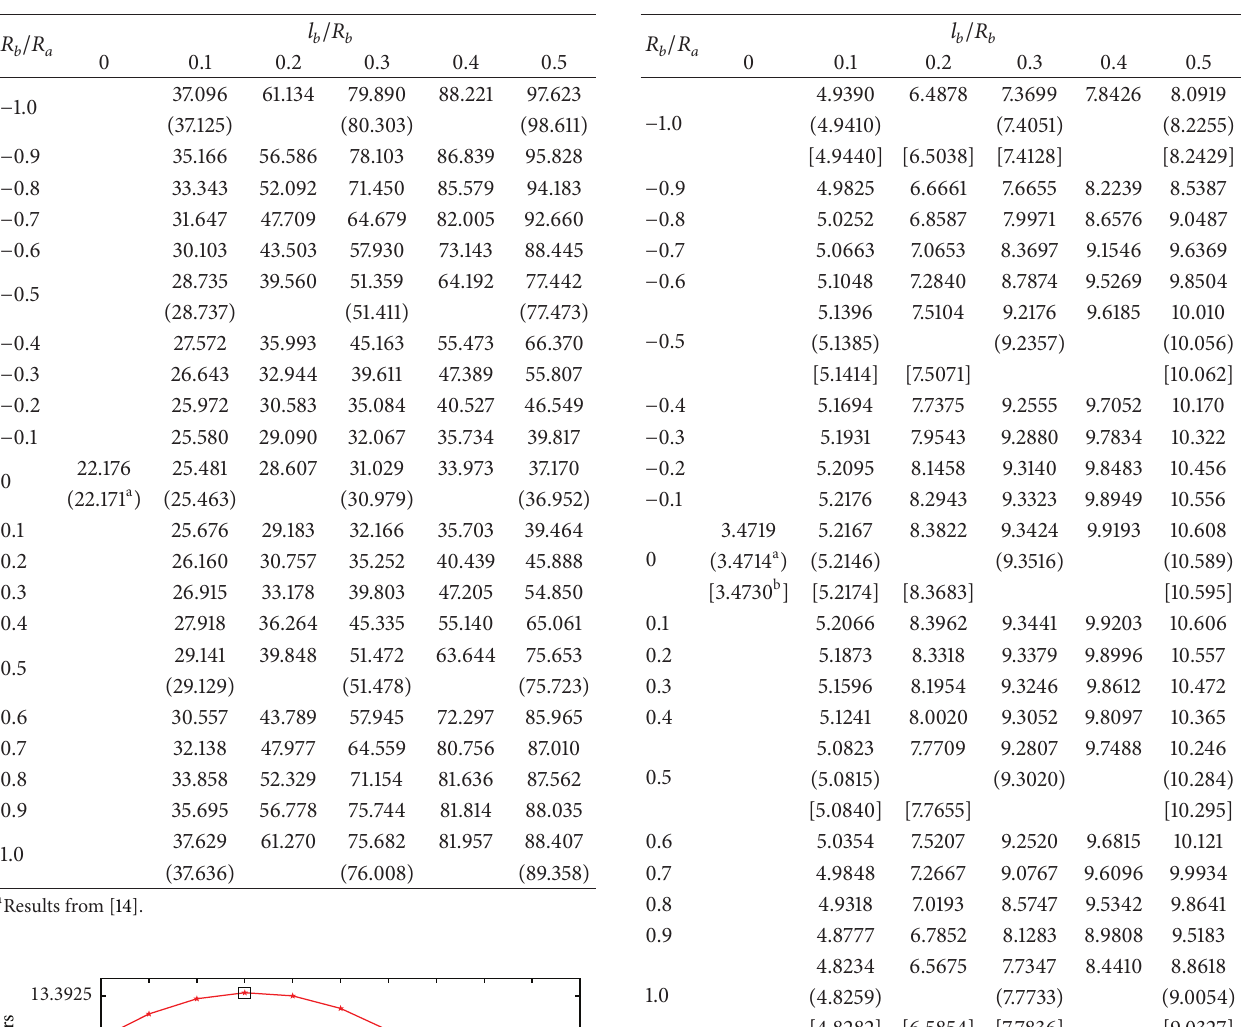
Table 8: The first frequency parameters of C-F-C-F shallow shells.